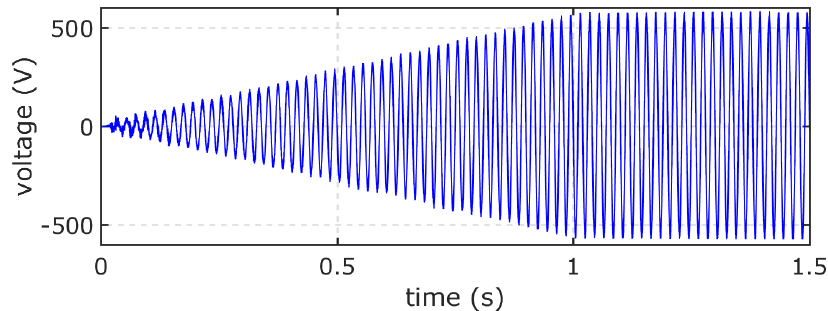
Figure 9. Voltage generation during start-up. Figure 8. Operation at variable load and constant wind seep [( a ) load power; ( b ) stator flux].